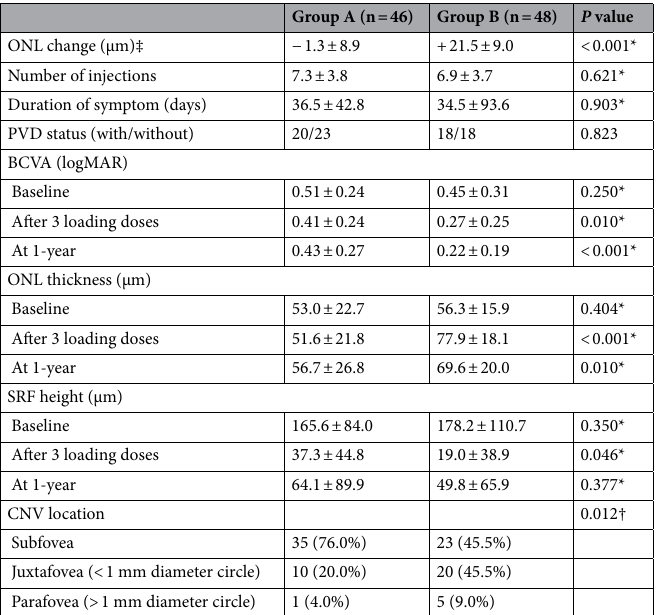
Table 3. A comparison between group A and group B. ONL outer nuclear layer, SRF subretinal fluid, CNV choroidal neovascularization, BCVA best-corrected visual acuity, logMAR log of minimum angle of resolution. * P values were calculated using the Student’s t test. † P value was calculated using the Fisher’s exact test. ‡ ONL change between the baseline and after 3 initial loading